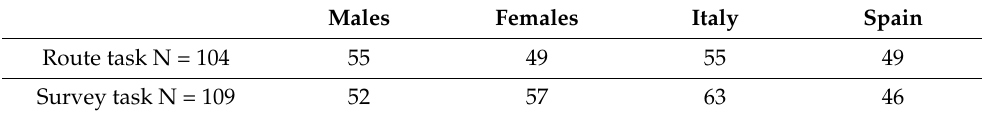
Table 1. The demographic features of the samples performing the Route and the Survey task,